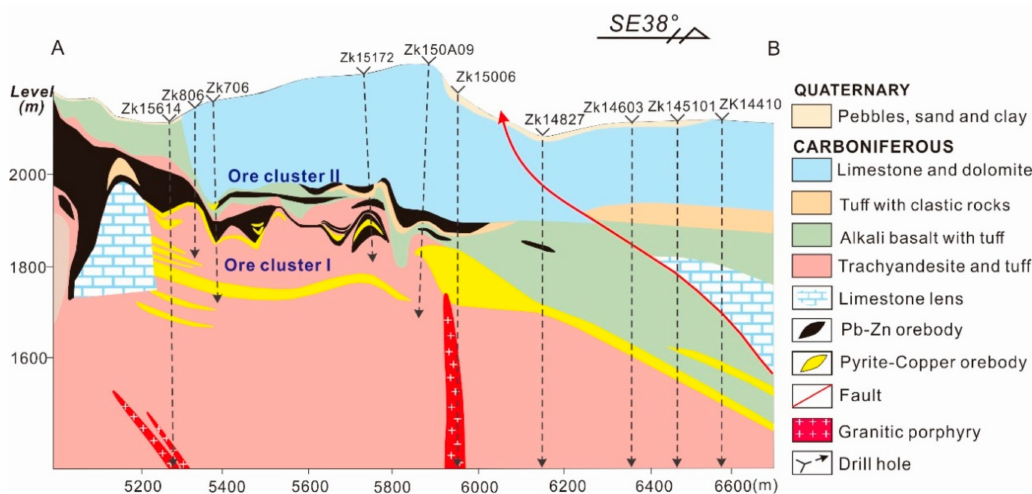
Figure 3. Geologic cross-section ( A , B ) showing the mineralization in the Laochang deposit (modified from Li et al.